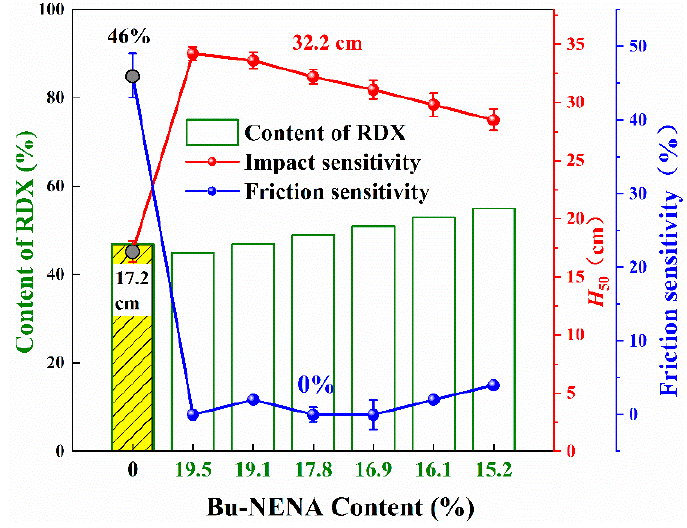
Figure 6. The friction and impact sensitivity of R series of propellants.